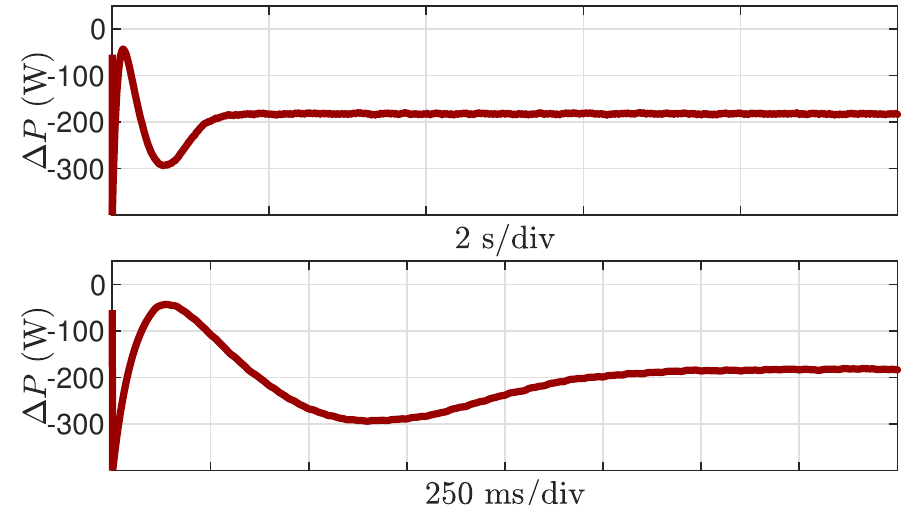
Figure 15. Test Case I: NLC ∆ P value obtained with “virtual V 2